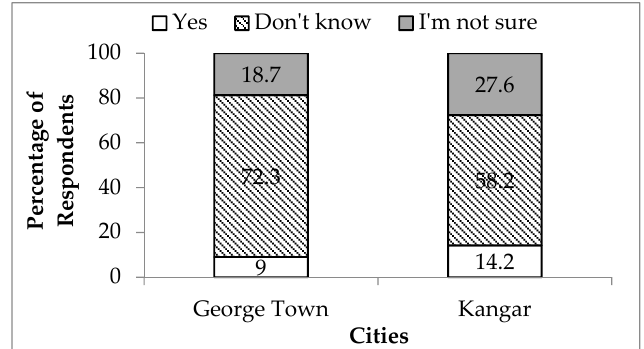
Figure 1. Public knowledge on NRW (Do you know what Non ‐ Revenue Water is?).